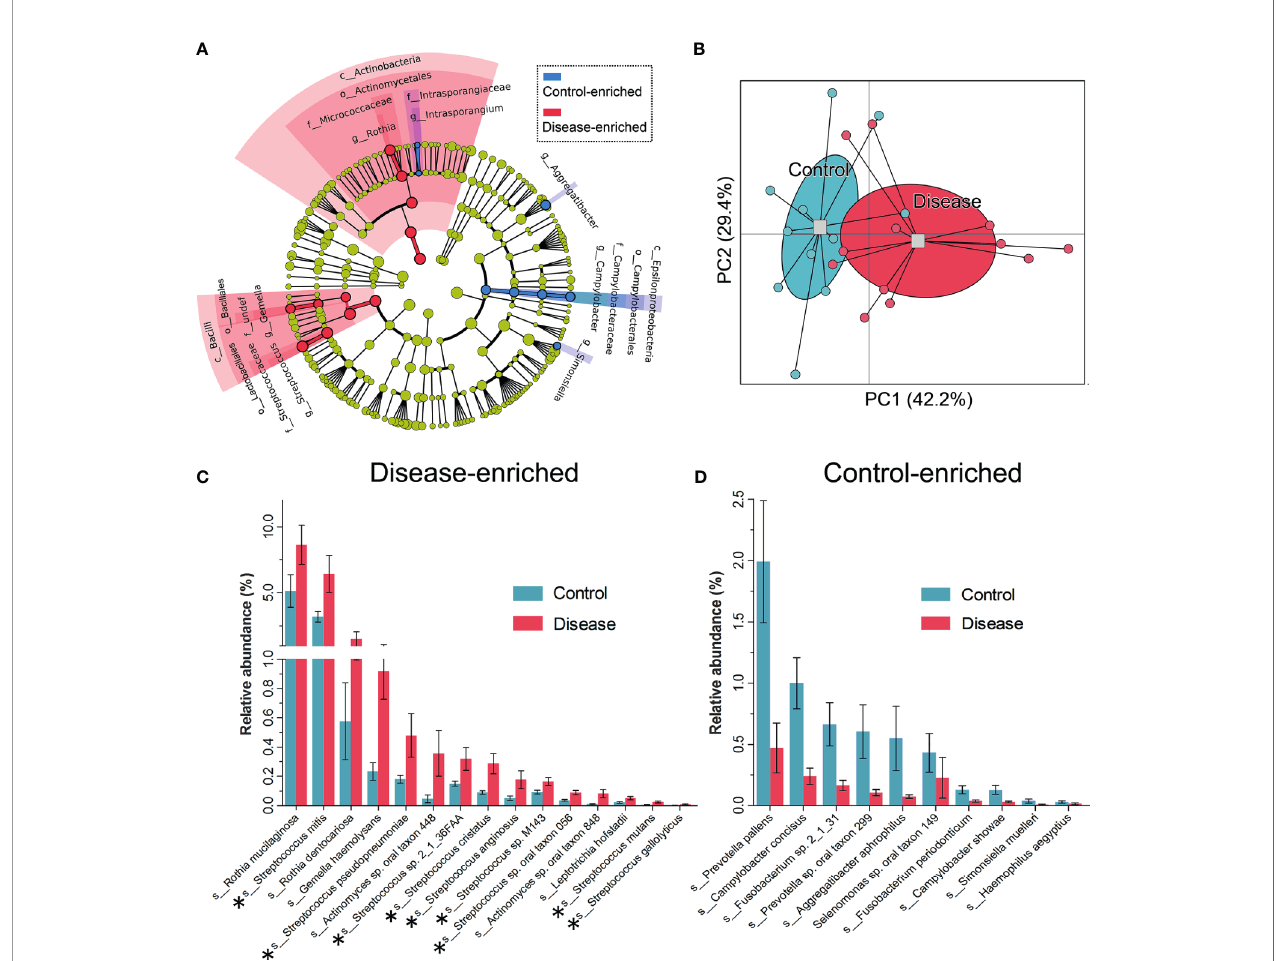
FIGURE 3 | Taxa differentiations between the HC and DIS group. (A) Taxa with signi fi cant differences in relative abundance at the phylum, class, order, family and genus levels are shown via taxonomic relationships. (B) Principal coordinates analysis based on the differentially present taxa using the Bray-Curtis distance. (C) Species enriched in the DIS group are shown, the bar represents the mean±sem. Members of Streptococcus are marked with “ * ” . (D) Species enriched in the HC group are shown, the bar represents the